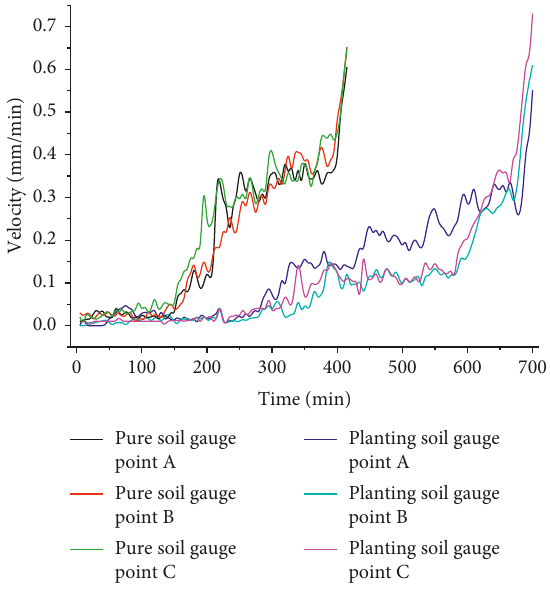
Figure 7: Total displacement value. Figure 8: Total slip rate.